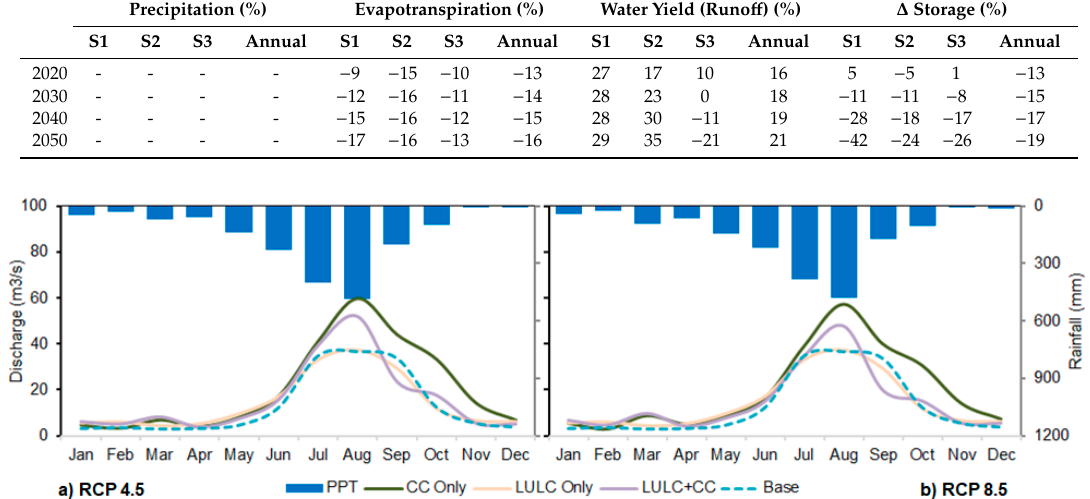
Table 4. Impacts of climate change on hydrology considering baseline data of 2010. S1 is pre-monsoon season (March–May); S2 is monsoon season (June–September); and S3 is post-monsoon season (October–February). Precipitation (%)